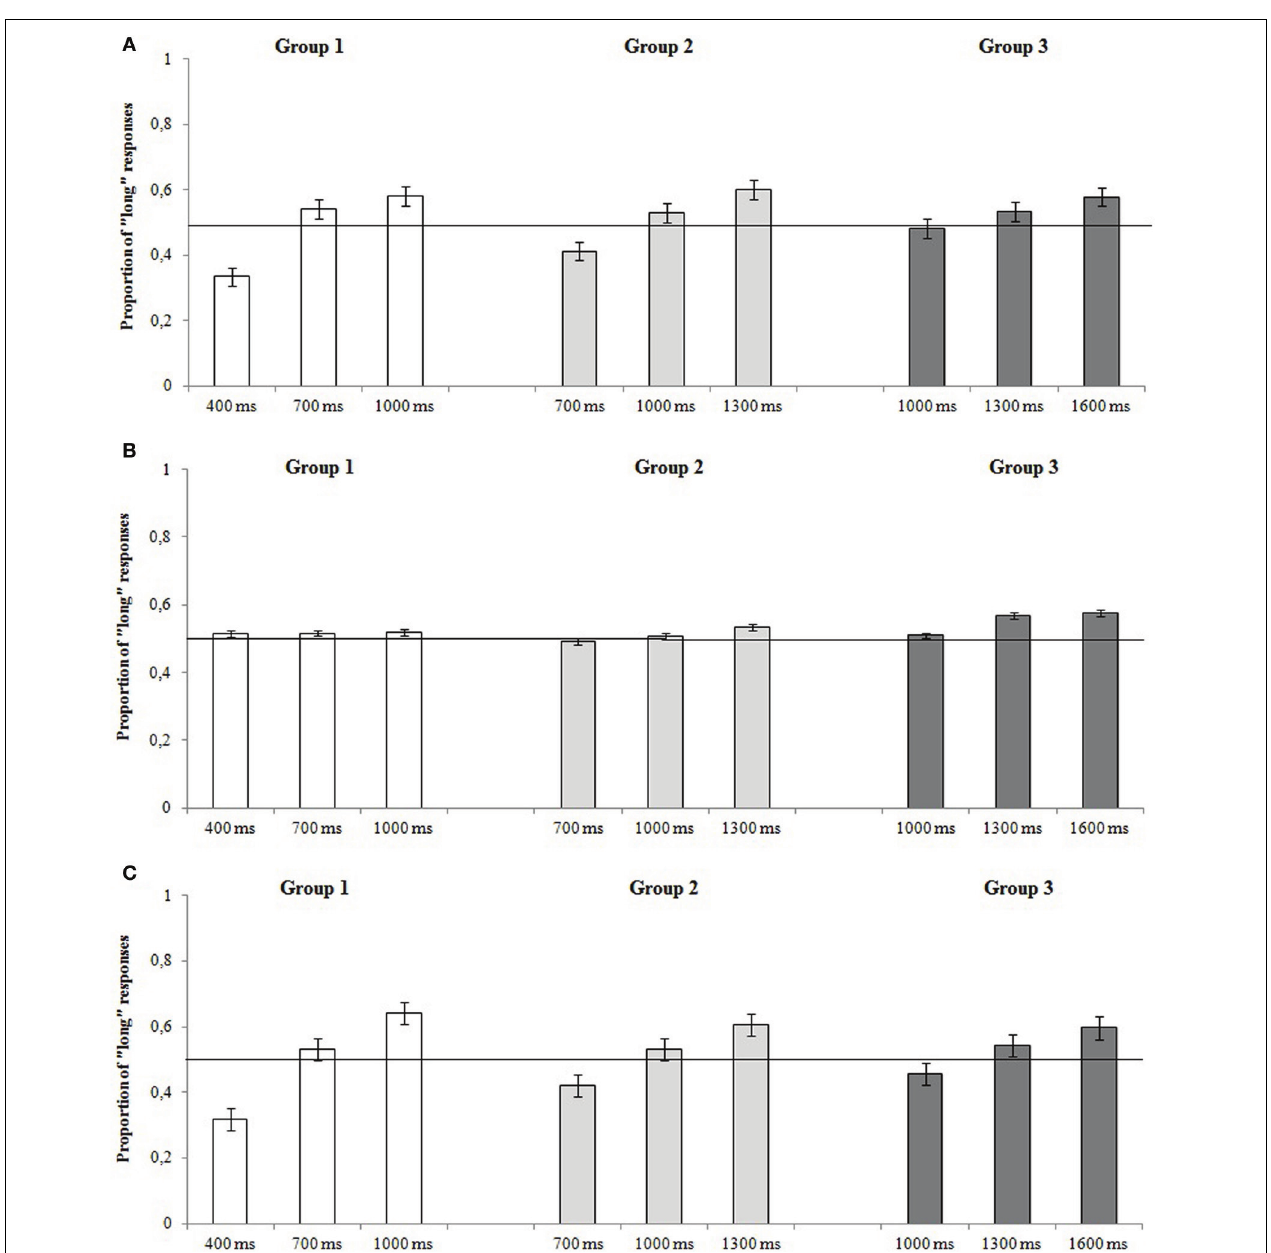
FIGURE 3 | Mean proportion of “long” responses in each group as a function of standard durations for (A) Experiment 1, (B) Experiment 2, and (C) Experiment 3. The error bars indicate standard errors.